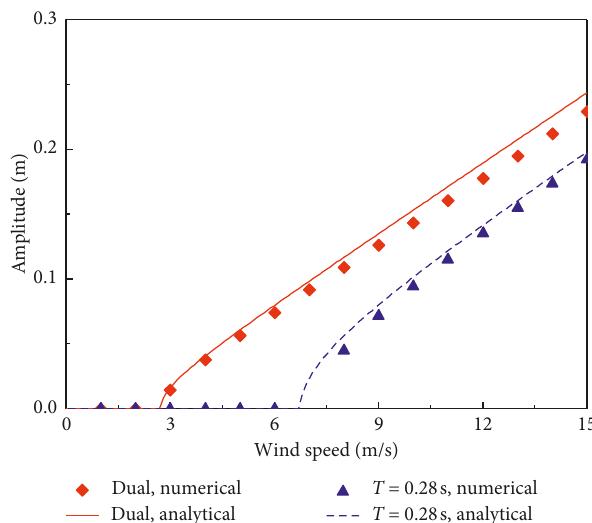
Figure 3: Variation of vibration amplitude of m for different